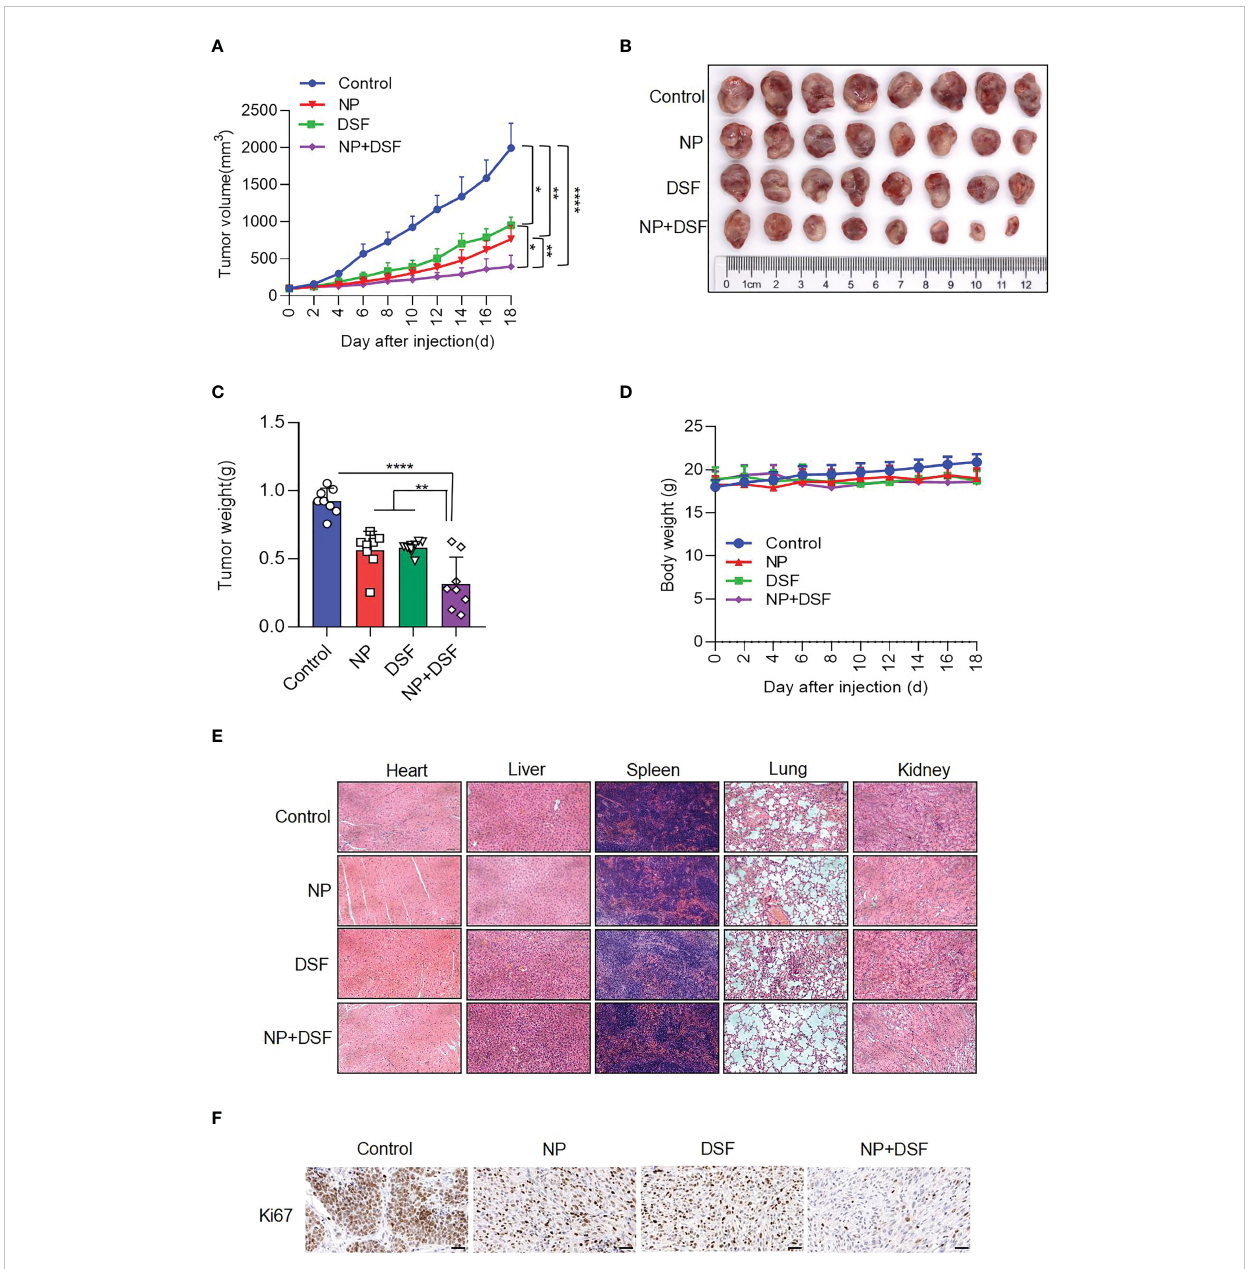
FIGURE 6 Disul fi ram combined with Niraparib suppresses ES-2-derived xenograft tumors in vivo . Female nude mice bearing ES-2-derived tumors were randomized into four treatment groups: DMSO, Disul fi ram (DSF, 50 mg/kg, daily by i.p.), Niraparib (NP, 50 mg/kg, daily by i.p.), and NP+DSF. After 18 days of treatment (A) tumor volumes were measured every 2 days. (B, C) . The tumors were photographed and weighed. (D) Body weight change was measured (E) . HE staining of the heart, liver, lung, kidney, and spleen from the four groups. (F) IHC staining of Ki67. Scale bars, 50 µm. * P <0.05; ** P <0.01; **** P